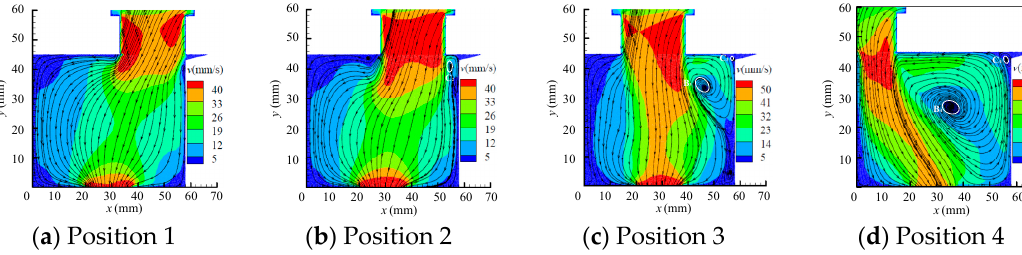
Figure 11. Velocity contours and streamlines with a piston moving speed of 12.5 mm/s.